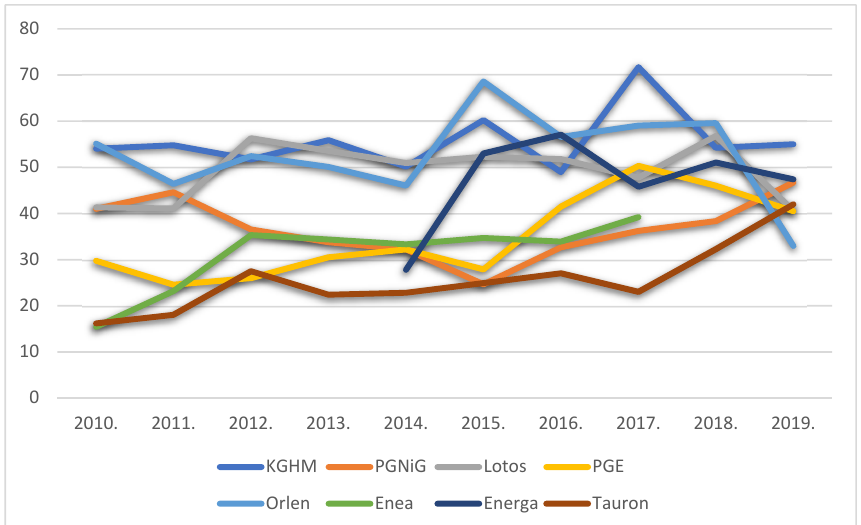
Figure 2. Changes in average annual values of ESG Combined indicator noted by the analysed enterprises in the period of 2010–2019. Source. Self-analysis.